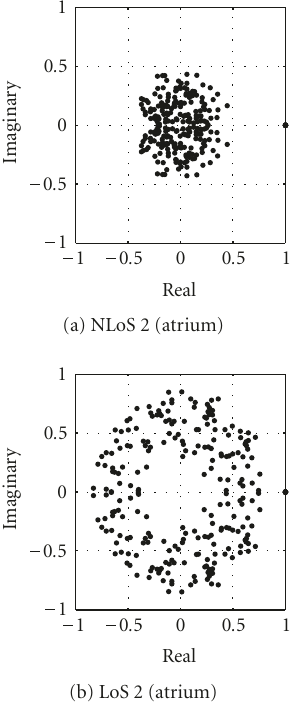
Figure 5: Complex correlation coe ffi cient of 4 for one of the OFDM subcarriers.